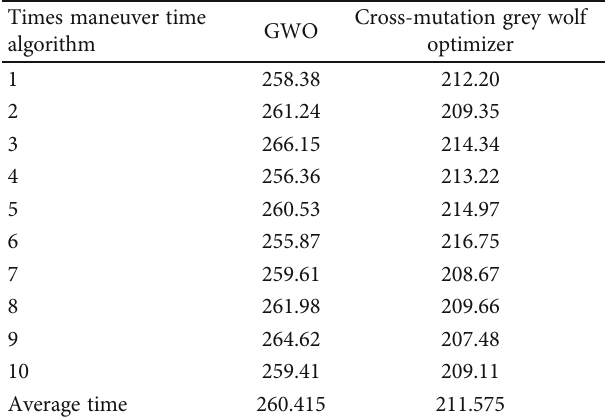
Figure 8: The computation time curve of the cross-mutation grey wolf optimizer. Table 3: Algorithm simulation experiment data comparison.